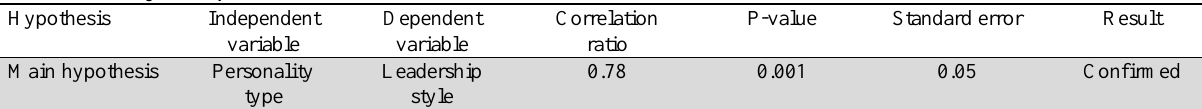
The summary of Spearman correlation